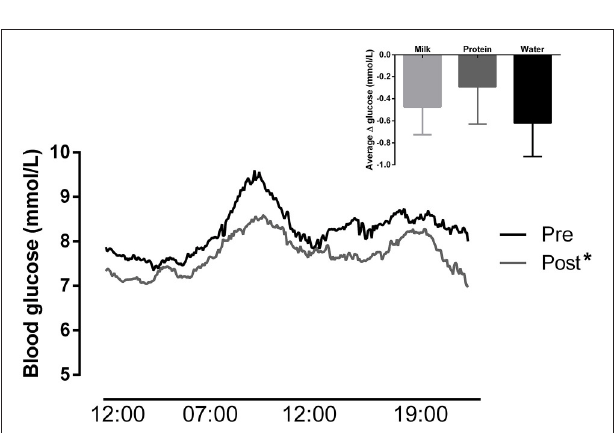
FIGURE 2 | Continuous blood glucose across 24-h ( n = 48) before and after the intervention (groups collapsed, *main effect of time: p = 0.01). Inset: Change in blood glucose after the intervention in the milk, protein, and water